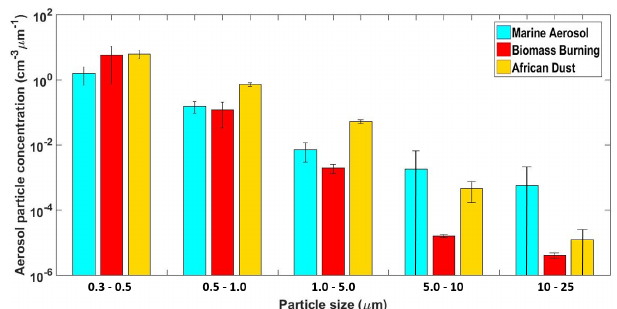
Figure 6. Average aerosol size distribution derived from the optical particle counters for the three air masses: MA (cyan bars), AD (yel- low bars), and BB (red bars). The error bars represent the standard